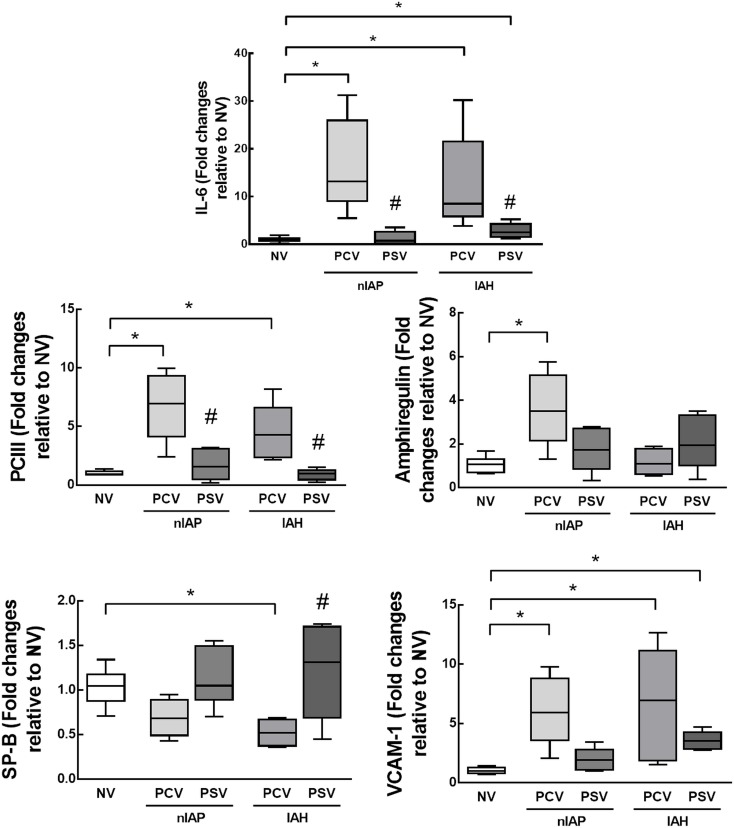
Real-time polymerase chain reaction analysis of biological markers associated with inflammation (interleukin [IL]-6), fibrogenesis (type III procollagen [PCIII]), pulmonary stretch (amphiregulin), type II epithelial cell damage (surfactant protein [SP]-B), and endothelial cell damage (vascular cellular adhesion molecule [VCAM-1]) in animals with normal intra-abdominal pressure (nIAP) or intra-abdominal hypertension (IAH) mechanically ventilated in pressure-controlled ventilation (PCV) or pressure support ventilation (PSV) mode.Values are given as medians, interquartile ranges, and minimum/maximum of 6 animals in each group. Relative gene expression was calculated as a ratio of average gene expression compared with the reference gene (36B4) and expressed as fold change relative to non-ventilated (NV) animals. *Significantly different from NV (p<0.05). #Significantly different from PCV (p<0.05).